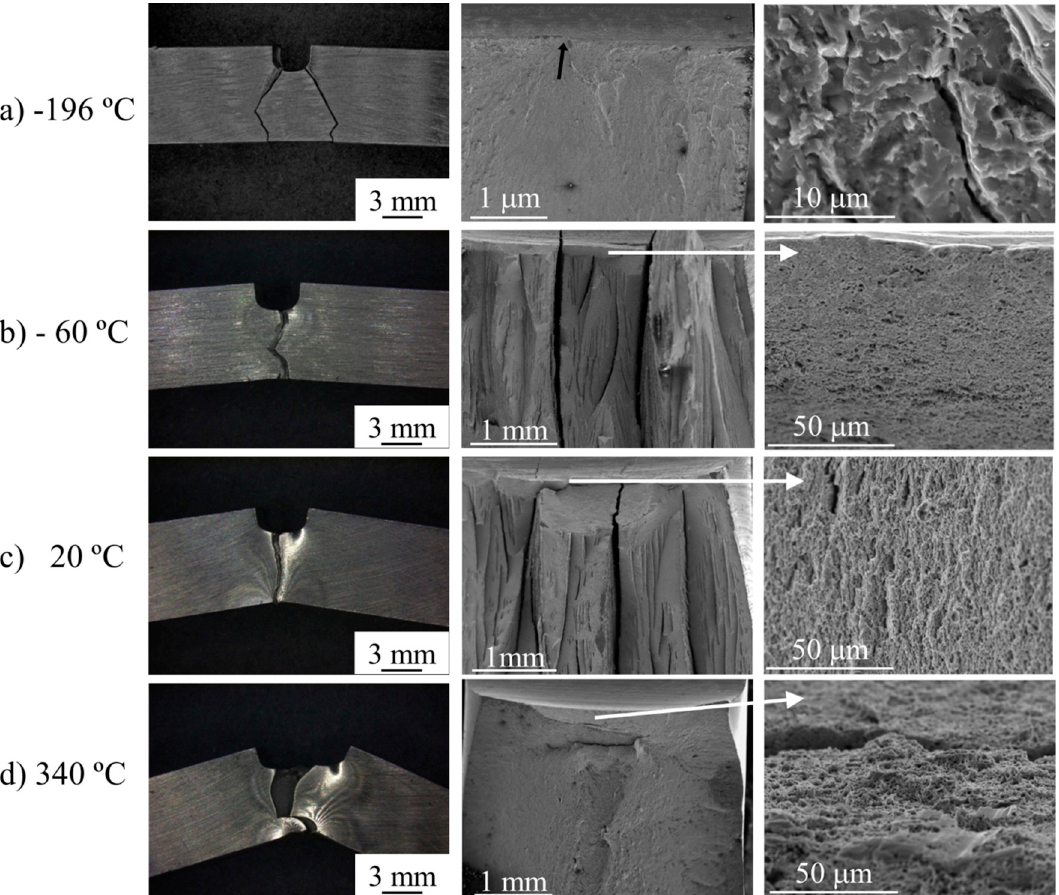
Figure 8. Appearances of LT ‐ notched Charpy impact test specimens of the PM2000 alloy after fracturing at ( a ) − 196 °C; showing the fracture profile (left), the fracture initiation point on the fracture surface ( middle ), and the microscopic features at high magnification ( right ); ( b ) − 60 °C; showing the fracture profile ( left ), the delamination on the fracture surface ( middle ), and the microscopic features of the fracture between delaminations ( right ); ( c ) +20 °C; showing the fracture profile ( left ), the delaminations on the fracture surface ( middle ), and the microscopic features of the fracture between delaminations ( right ); ( d ) 340 °C; showing the fracture profile ( left ), the ductile aspect of the fracture surface with a delamination parallel to the notch basis ( middle ), and the microscopic features between delaminations ( right ).